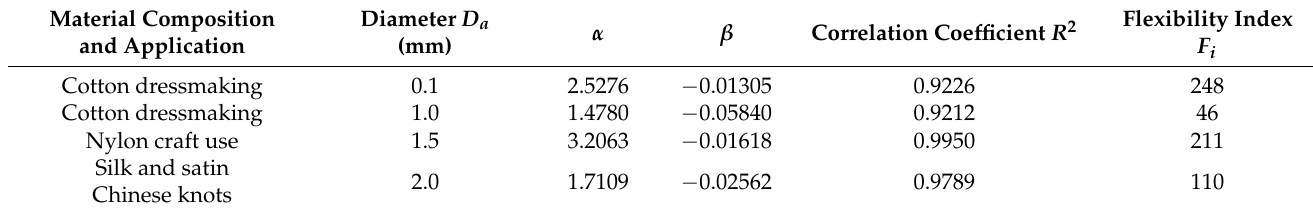
Figure 4. Relationship between L w / L a and L a / Table 1. Flexibility index of strips made of different materials and